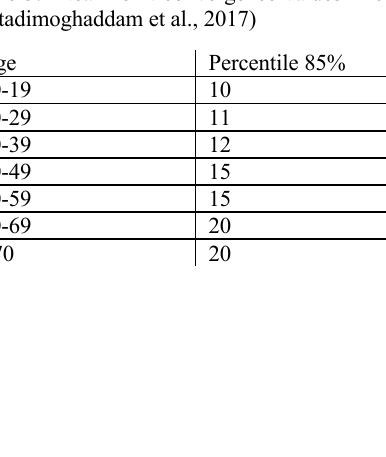
Table 3: Near Point convergence values in centimeters by